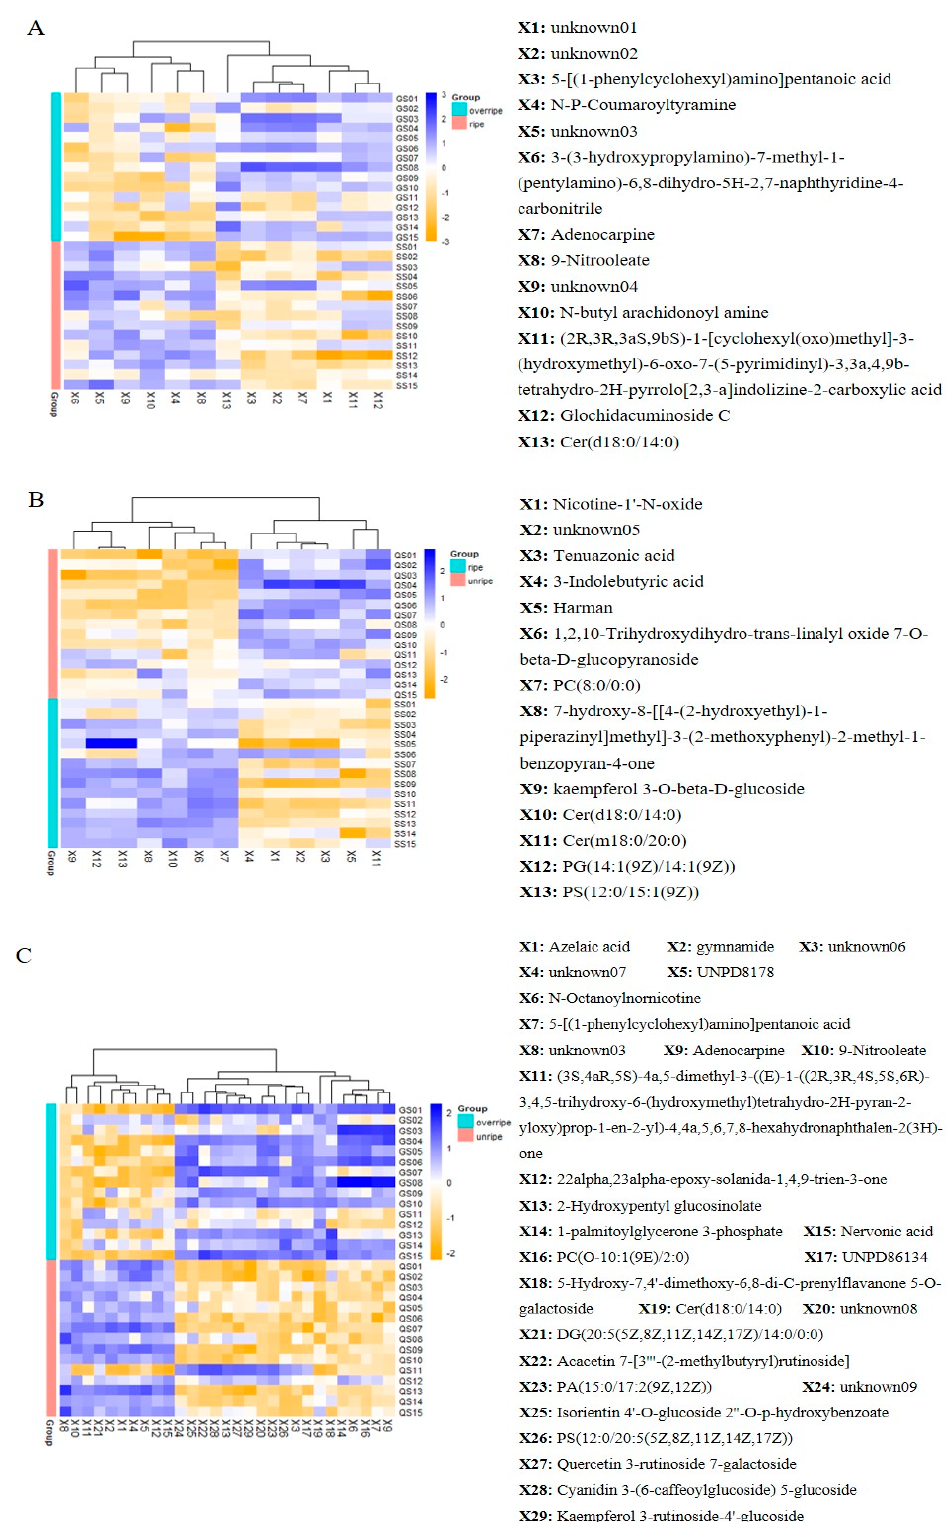
Figure 10. Results of hierarchical cluster analysis (HCA) of the flue-cured NTL leaves from different maturity grades. ( A ) HCA of differential metabolites between overripe and ripe leaves; ( B ) HCA of differential metabolites between unripe and ripe leaves; ( C ) HCA of differential metabolites between unripe and overripe leaves.